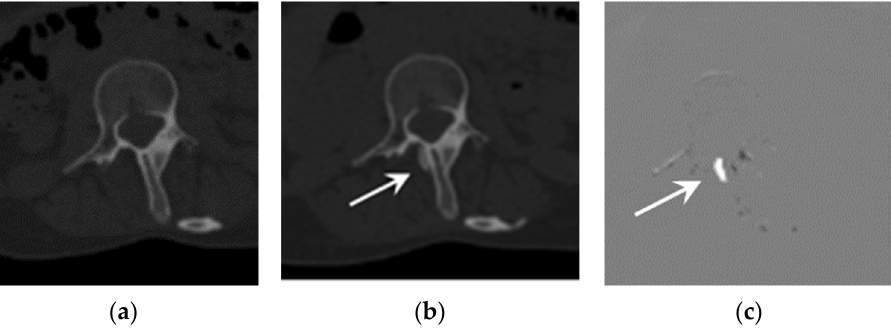
Figure 1. Example of an emerging lesion. CT images of a 25-year-old FOP patient: ( a ) previous CT image, ( b ) current CT image, and ( c ) TS (subtraction) image. The emerging lesion adjacent to the thoracic spine (arrow) is difficult to detect on the current CT image, but is clearly visible in the TS image.